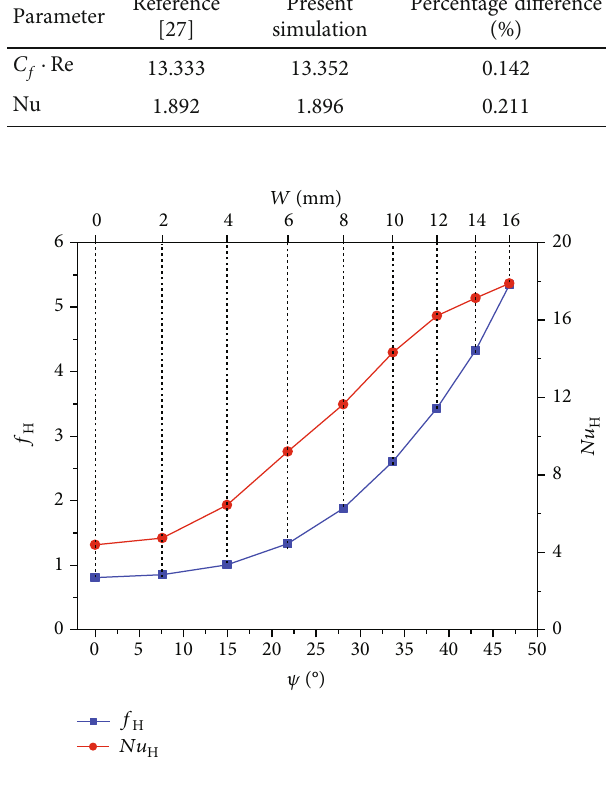
Figure 8: Friction factors and Nusselt numbers as a function of angle ψ